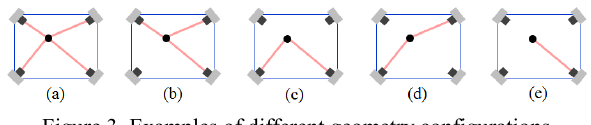
Figure 3. Examples of different geometry configurations between cameras and target object